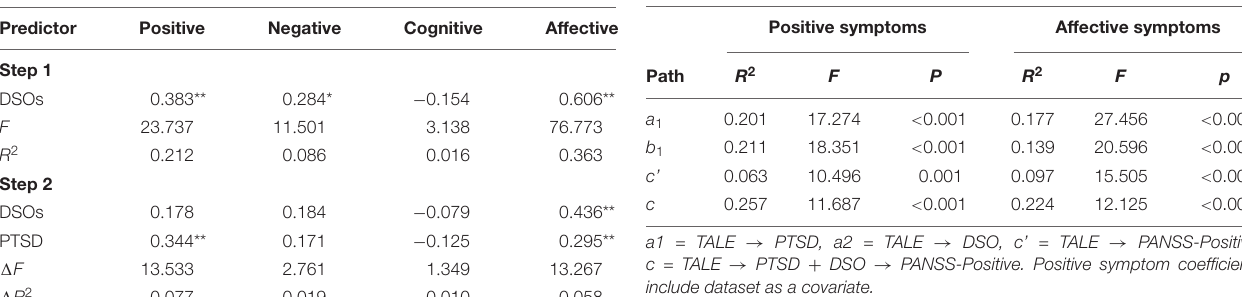
TABLE 3 | Regression statistics for the mediation pathways predicting psychotic symptoms.